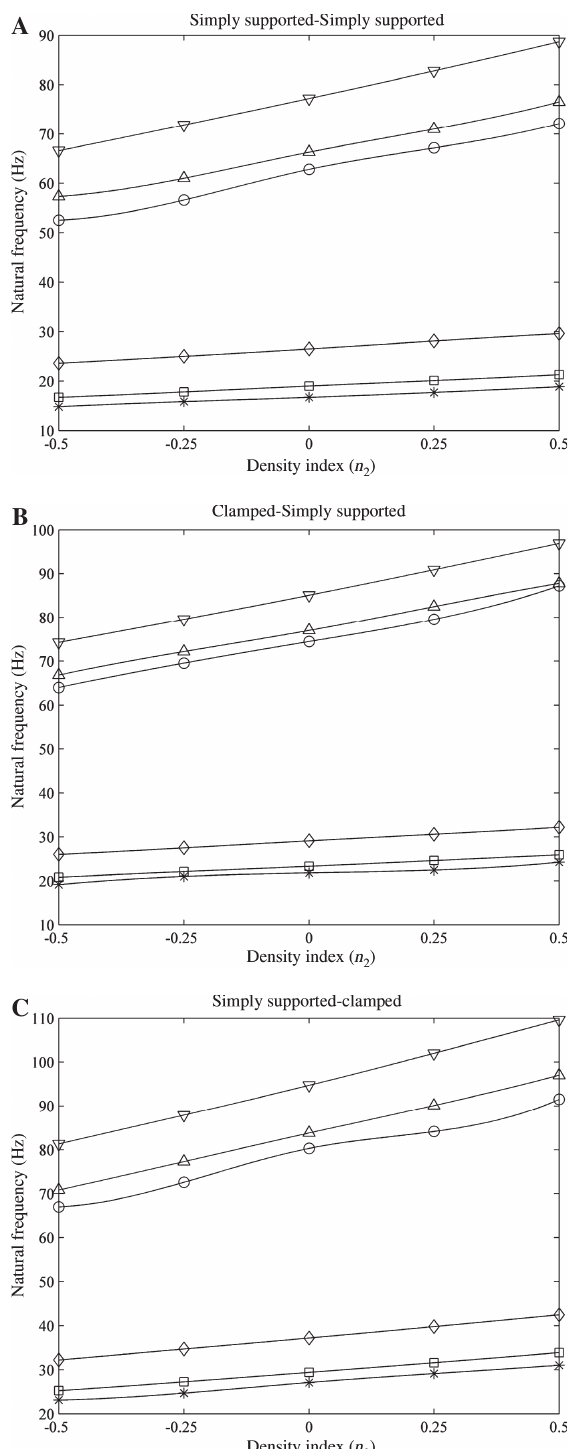
variations on the natural frequency of the disc Figure 3 Effects of n 2 for (A) S-S, (B) C-S, and (C) S-C boundary conditions. * ( m = 0; n = 1), ○ ( m = 0; n = 2), □ ( m = 1; n = 1), ∆ ( m = 1; n = 2), ◊ ( m = 2; n = 1), ∇ ( m = 2; n =